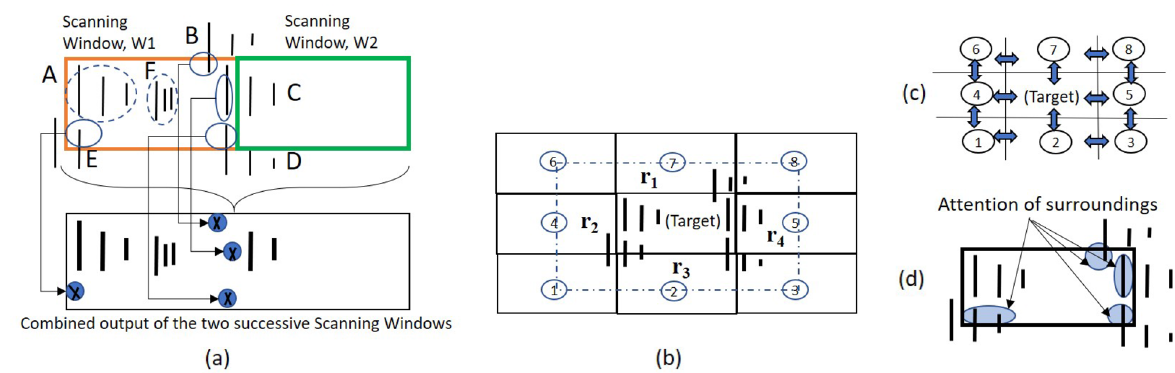
Figure 4. ( a ) We show two successive and non-overlapping scanning windows, W1 and W2, and six features: A, B, C, D, E, and F. We show the combined output of the two successive scanning windows in the bottom image. Feature A and F are fully contained within W1. Therefore, all of its isotopic signals are correctly detected, as shown in the combined output. However, for each of the other four features, W1 sees partial traces shown by small circles in the upper image. Without any background knowledge, those traces are not adequate for deciding whether they belong to real features or merely noisy traces. We mark the isotopes by a cross sign which are not detected. The second window W2 detects two isotopes of feature C. But the system missed the monoisotope of feature C, which is treated as missing the feature as a whole. ( b ) Surrounding regions of a target window. ( c ) 2D bi-directional RNN to flow the surrounding information towards the target window in center. ( d ) Attention of surrounding regions over the datapoints of target